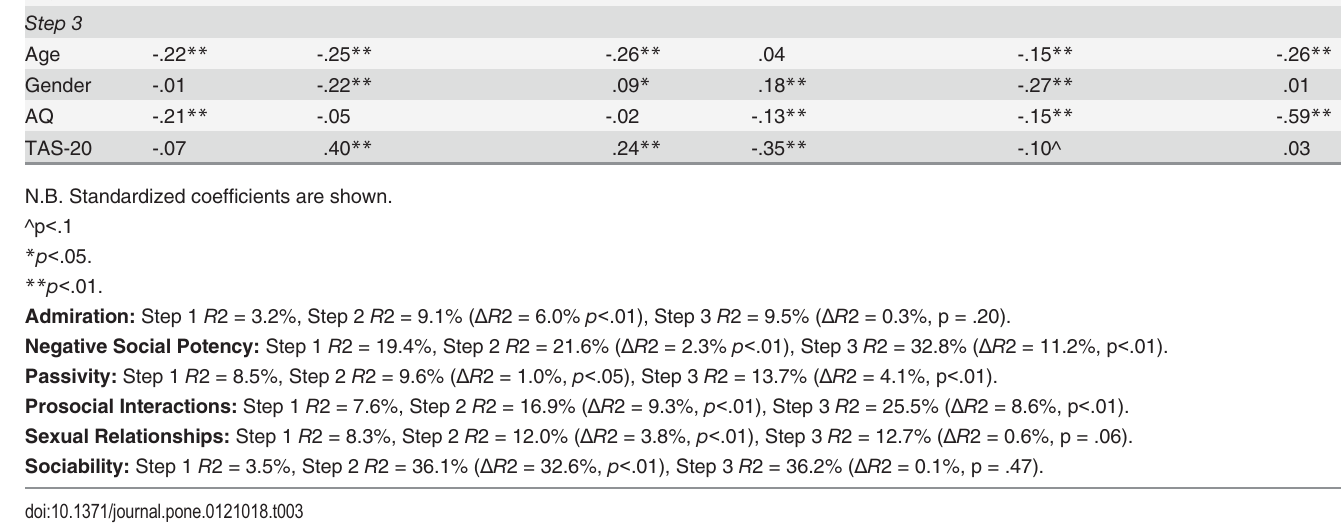
Regressions tion, negative social potency, passivity, prosocial interactions, sexual relationships and sociabil- ity (see Table 3). Age and gender were entered in Step 1 of each model, autistic traits were entered in Step 2, and alexithymia was entered in Step 3 using the enter method in SPSS.